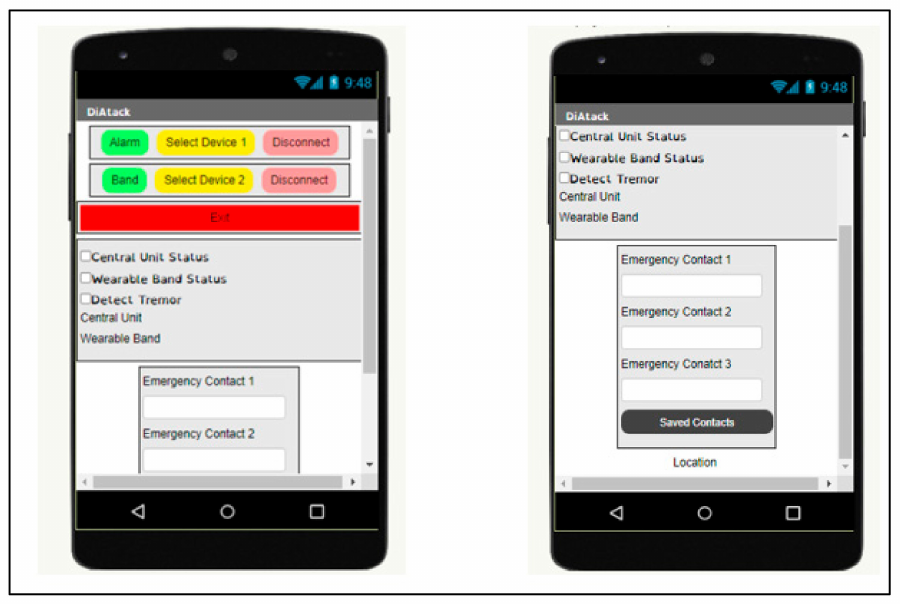
Figure 11. DiAtack Mobile